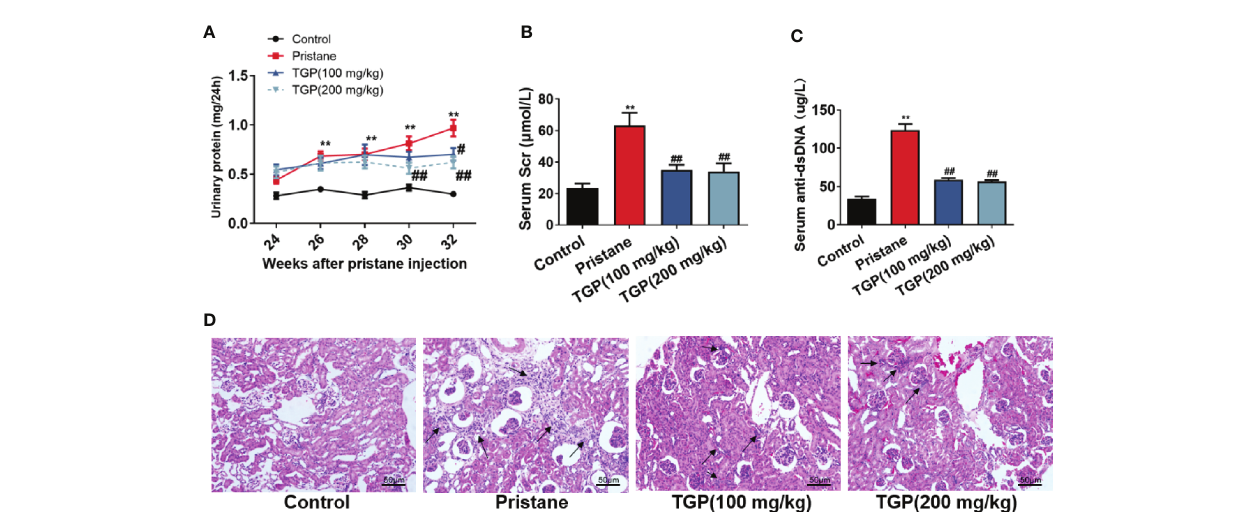
FIGURE 1 | TGP treatment improves renal pathology and function in mice with pristane-induced lupus nephritis. (A) 24 weeks after pristane injection, 24-h urinary protein was determined every two weeks and mice with >0.4 mg/24h urinary protein were also treated with total glucosides of paeony (TGP) in subsequent experiments starting at the same 24-week point. The effects of TGP on kinetics of 24-h urinary protein in pristane-induced lupus mice were observed. In addition, eight weeks after TGP treatment, the serum creatinine (Scr) (B) and serum anti-ds-DNA (C) were measured using sarcosine oxidase creatinine assay kits and murine anti-dsDNA standard enzyme-linked immunosorbent assay (ELISA) kits, respectively. Data are presented as means ± SD (n=5-6, ** p < 0.01 compared with control, and ## p < 0.01 or # p < 0.05 compared with pristane-treated mice). (D) HE staining of the kidney in the pristane-induced lupus mice 8 weeks after TGP treatment (200×, with black arrows pointing to in fi ltrating immune